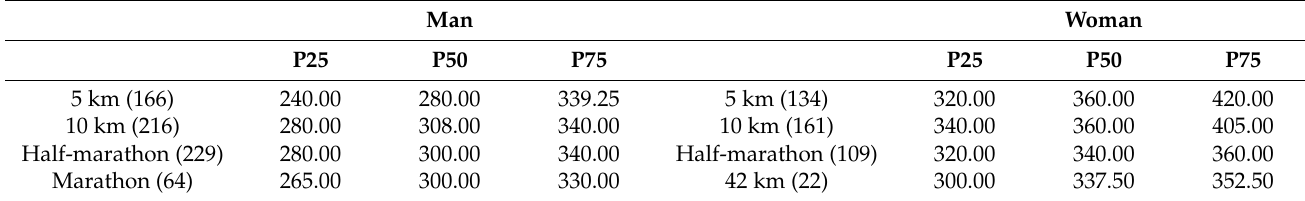
Table 3. Running pace (sec/km) percentiles by sex and running